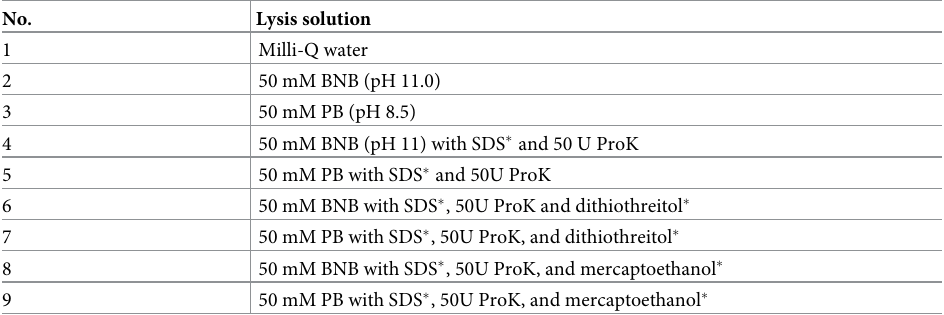
Table 2. Lysis solutions